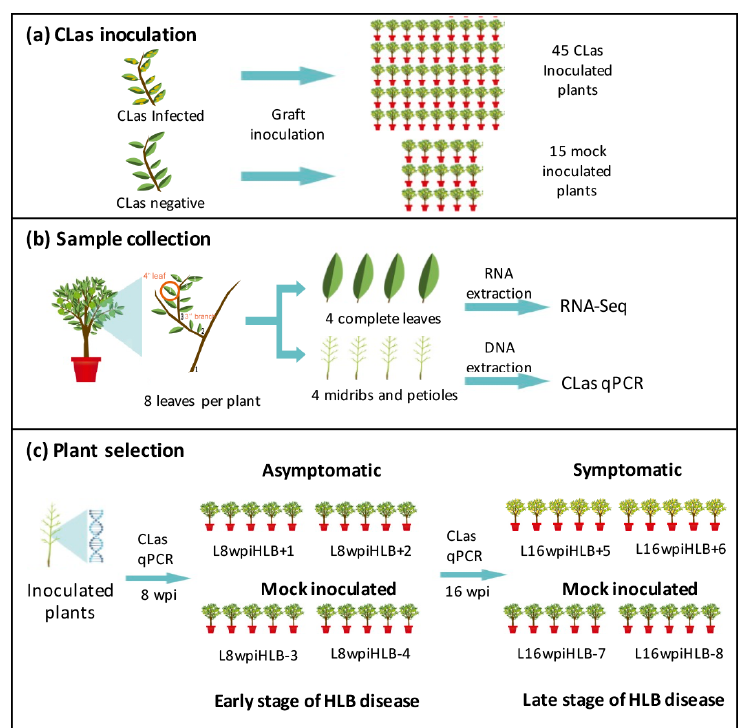
Figure 1. Flowchart of the experimental design used to inoculate Candidatus Liberibacter asiaticus (CLas) in C. aurantifolia and to select plants to be included in the 8 libraries for RNA-seq analysis. ( a ) CLas inoculation by grafting. Forty-five Mexican lime plants were inoculated with CLas-positive budwood, and 15 plants were inoculated with CLas-free budwood as controls; ( b ) sample collection of 8 leaves per plant for RNA and DNA extraction. In all cases, the fourth leaf of 8 different branches located at third level of ramification from the main stem was collected in order to obtain a homogeneous representation of source tissue; ( c ) plant selection by qPCR at 8 and 16 wpi (weeks post inoculation) to construct each library. Libraries L8wpiHLB+1 and L8wpiHLB+2 included 5 pooled asymptomatic plants. Libraries L16wpiHLB+5 and L16wpiHLB+6 included 5 pooled symptomatic plants. Control libraries, L8wpiHLB-3 and L8wpiHLB-4 at 8 wpi and L16wpiHLB-7 and L16wpiHLB- 8 at 16 wpi, were constructed by pooling 5 mock-inoculated plants.